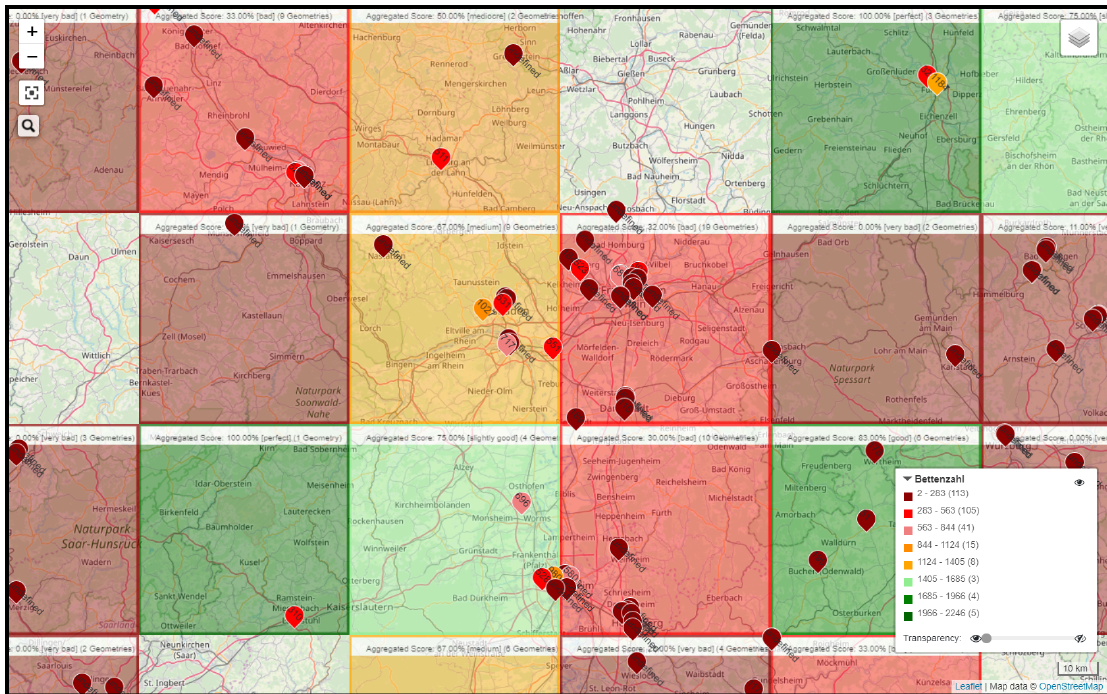
Figure 11. Thematic Map Hospital_Capacity exposing the number of beds available in a clinic, including a data quality layer giving a quality estimation of the map. Rescue operators may use this information to plan rescue contingencies in case of a disaster such as a flood. The coverage of the relevant information according to the requirement profile looks usable in this particular